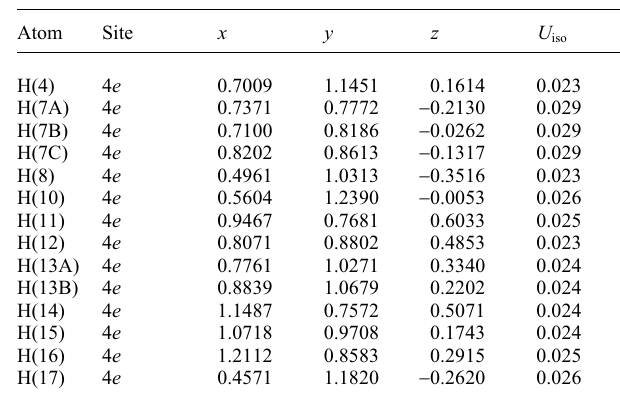
Table 2. Atomic coordinates and displacement parameters (in Å 2 )